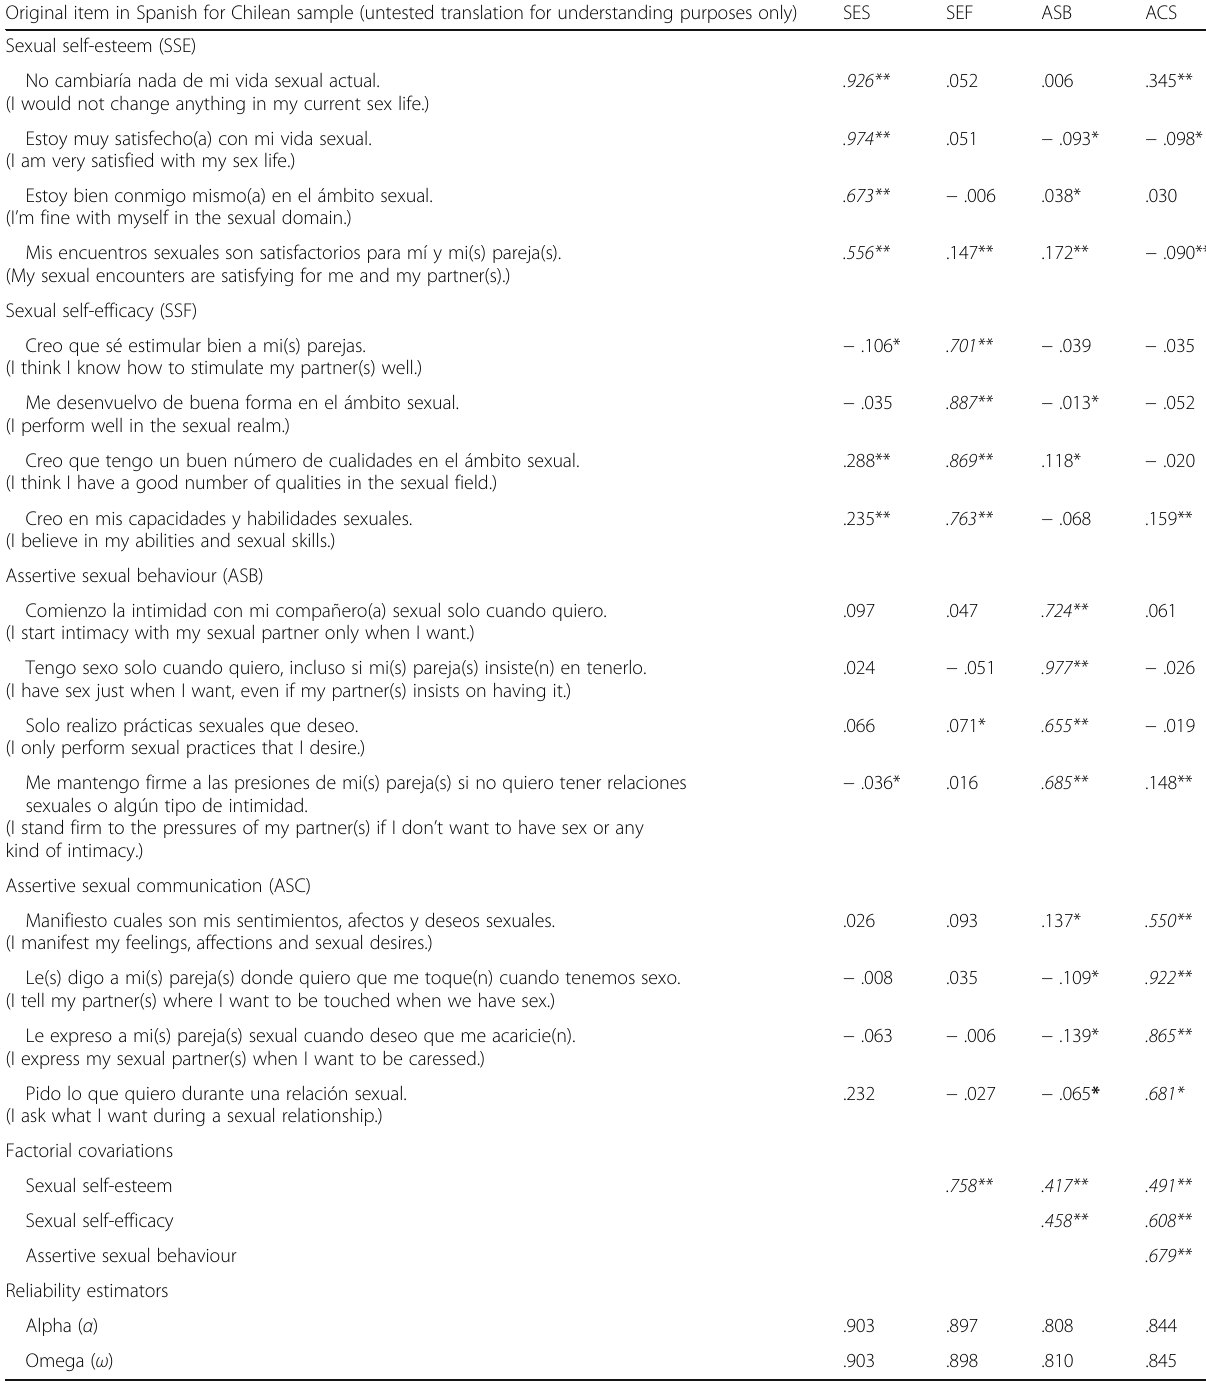
Table 2 Standardised factorial loadings reliability coefficients (Cronbach ’ s Alpha and McDonald ’ s omega) for each dimension Original item in Spanish for Chilean sample (untested translation for understanding purposes